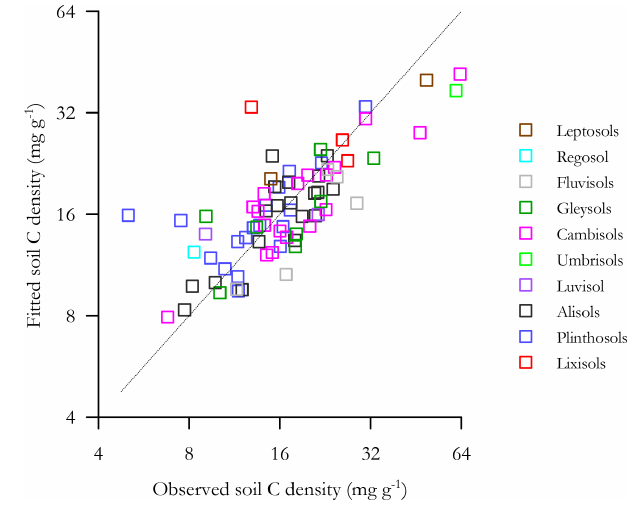
Figure 10. Fitted vs. observed SOC densities for regression model 6s (Table